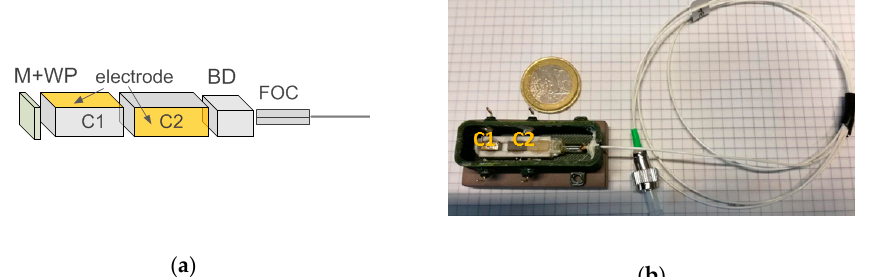
Figure 1. OVS sensor. ( a ) retracing scheme of the optical transducer: fiber optic collimator (FOC), Lithium Tantalate (LiTO3) crystals (C1 and C2), Beam Displacer (BD), Mirror and λ /8 waveplate (M+WP); ( b ) picture of the developed OVS prototype